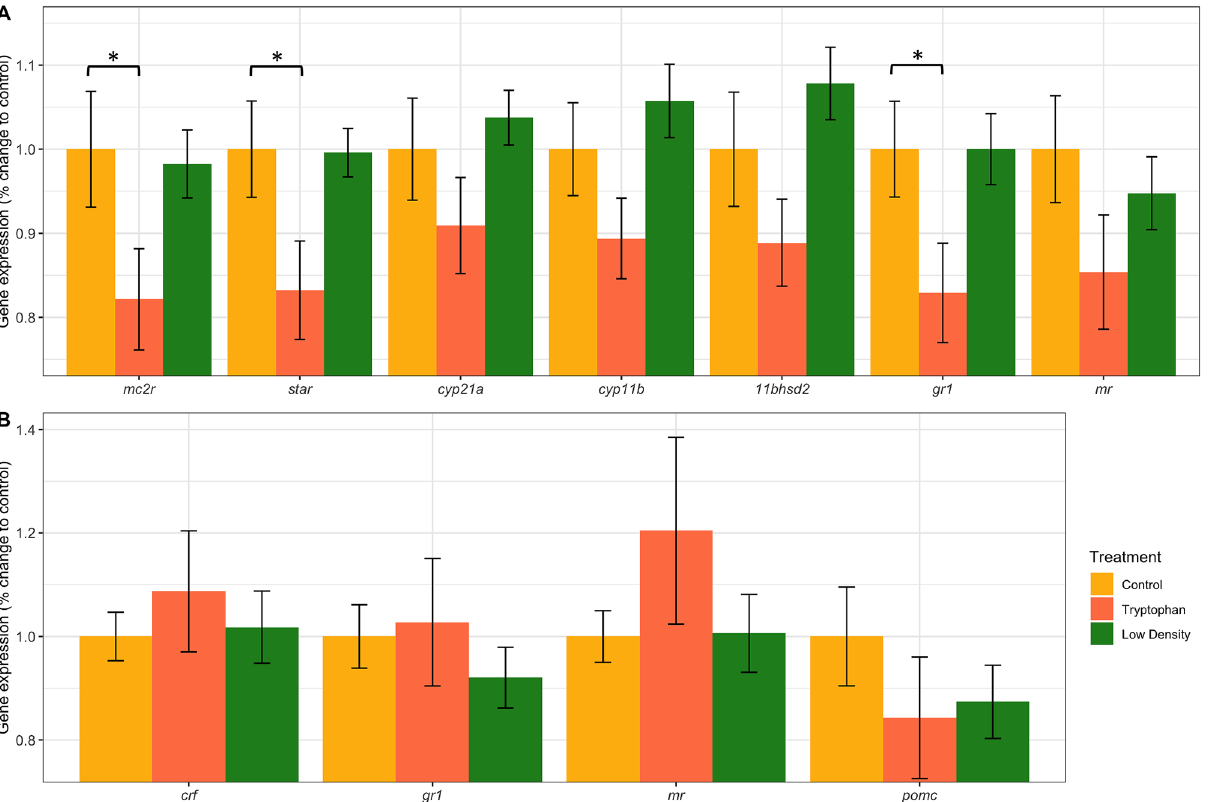
Figure 2. Gene expression of ( A ) mc2r, star, cyp21a, cyp11b, hsd11b2, gr1 and mr in the whole trunk of juveniles and ( B ) of crf, gr1, mr and pomc in the head of juveniles kept in the 3 different treatments: Control, Low density and Tryptophan. Note that these are values relative to the geometric mean of the following reference genes: ribosomal protein L13 ( L13 ) and eukaryotic translation elongation factor 1 alpha ( eef1a ). Each bar plot represents the difference in % between Control and the other treatments. “*” indicates a p value <